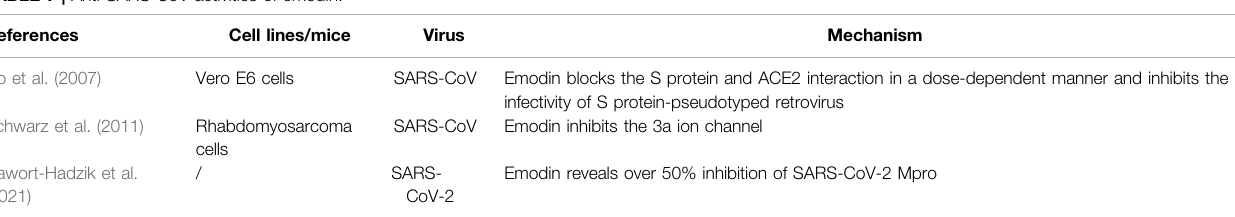
TABLE 7 | Anti-SARS-CoV activities of